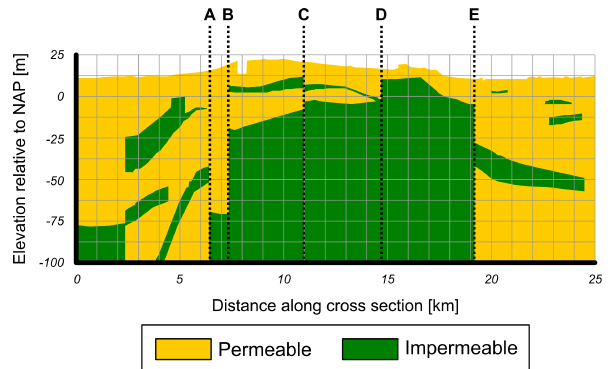
Figure 4. West–east cross section of the Raam catchment showing the permeable and impermeable layers of the subsoil, based on the geohydrological model REGIS II (Vernes and Van Doorn, 2005). The locations indicated by A, B, C, D and E refer to the position of the faults and correspond to the letters in Fig.